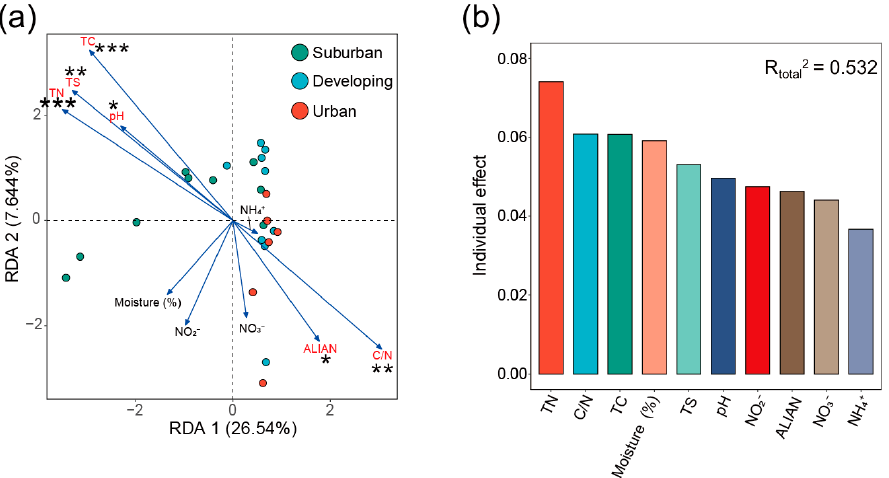
Figure 5. RDA (Redundancy analysis) of environmental factors and microbial communities ( a ), and the effect of each environmental factor on microbial community structure ( b ). Suburban, developing, and urban stand for the corresponding urbanization level for sampling. The dots in different colors represent the microbial samples along the urbanization gradient, and the length of the arrows of the physicochemical factors can represent the influence magnitude of the physicochemical factors. ALIAN—artificial light intensity at night. Moisture (%)—Water content (%) of camphor leaves with different urbanization levels. R total2 —Explanation rate of the full model (i.e., including all envi- ronmental factors). An asterisk denotes a significant statistical difference between treatments (*, p < 0.05; **, p < 0.01, ***, p < 0.001), and ns indicates that the statistical difference is not significant. Table 2. RDA (Redundancy analysis) of leaf phyllosphere microbiota of different urbanization levels.